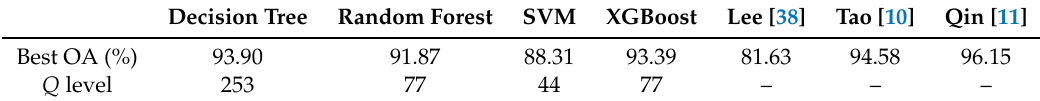
Table 9. OAs of different classifiers on AIRSAR Flevoland data set.